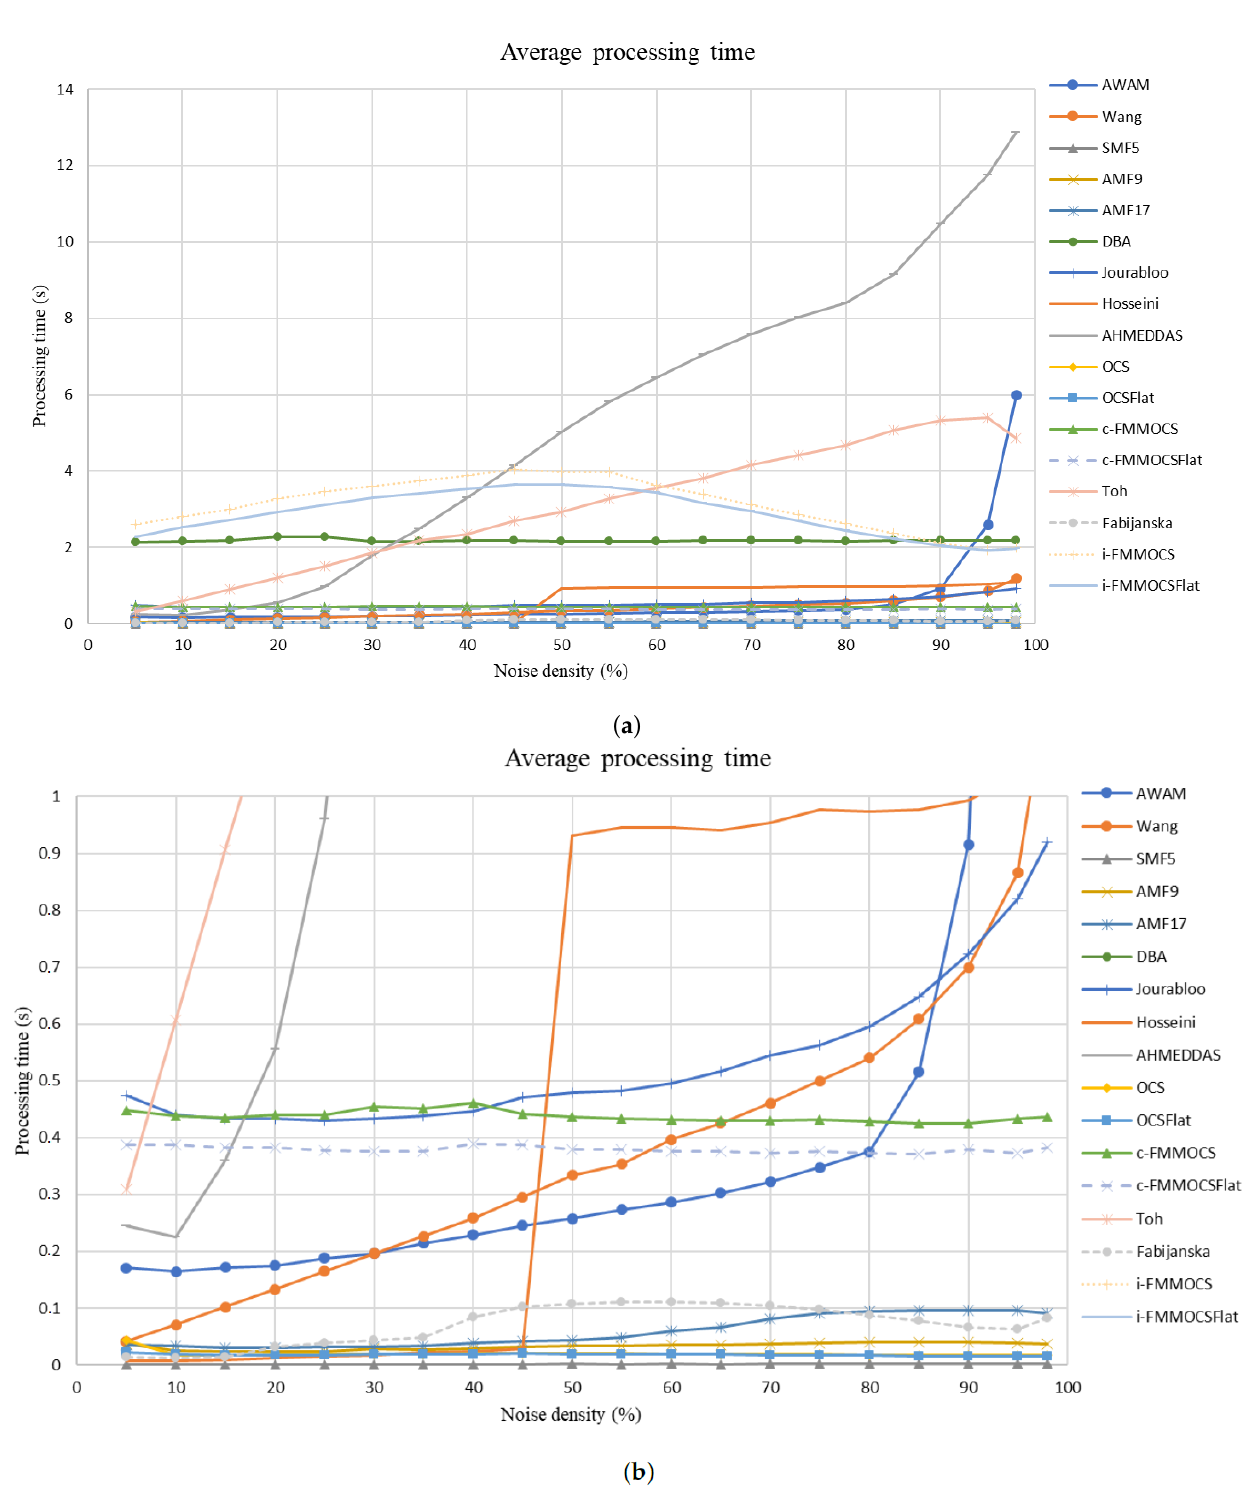
Figure 10. Evolution of the average computational processing times of all the filters for the images of the test set with respect to the considered noise densities. ( a ) Complete figure. ( b ) Zoomed figure for processing times less than 1